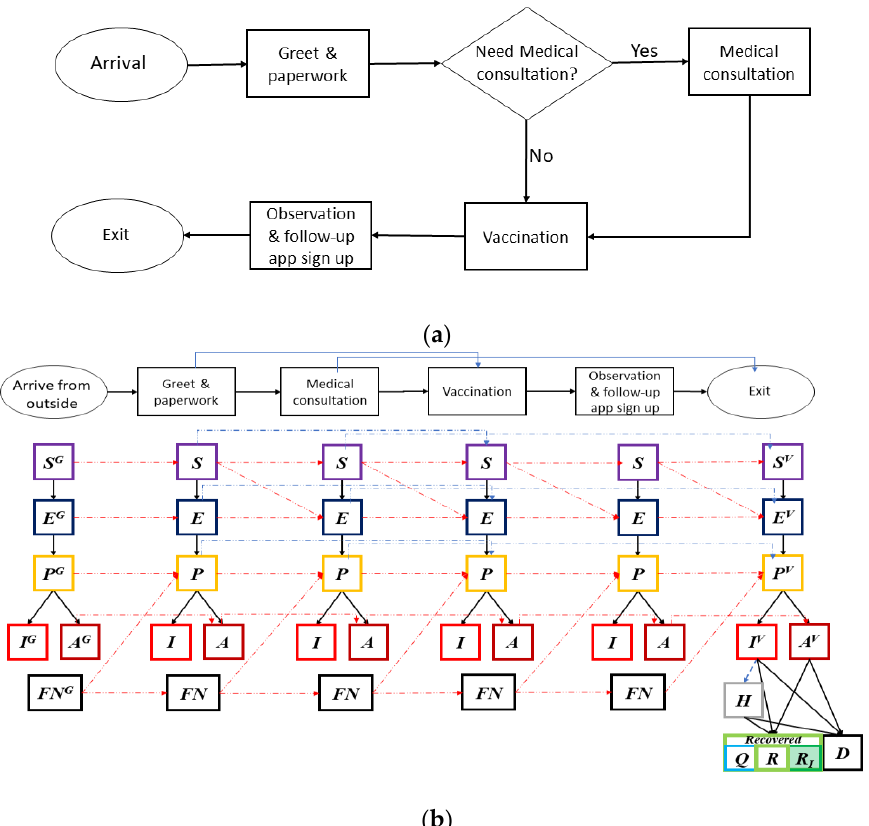
Figure 2. ( a ) A process flowchart of the COVID-19 point-of-dispensing (POD) operations. The service time at each station is fitted with real-life time-motion studies from multiple vaccination events. ( b ) Disease stages of individuals within each station of the POD, their interplay and progression dynamics. A susceptible individual at a station may become exposed and move to “Exposed” disease stage in the next station. False negative (FN) individuals may have recovered from COVID-19; or a newly FN individual can become infectious at some point inside the POD. Recovered individuals can be recovered with immunity ( R I ) or recovered without immunity ( R